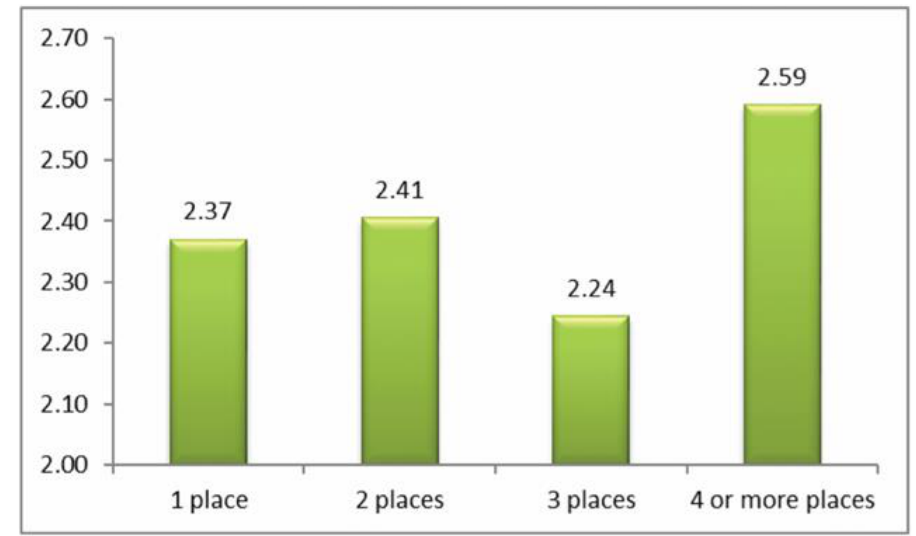
Figure 7. The risk of being a cybervictim (4-point scale), by numbers of sites used for internet for the adolescents who were cyberbullied ( n = 163).